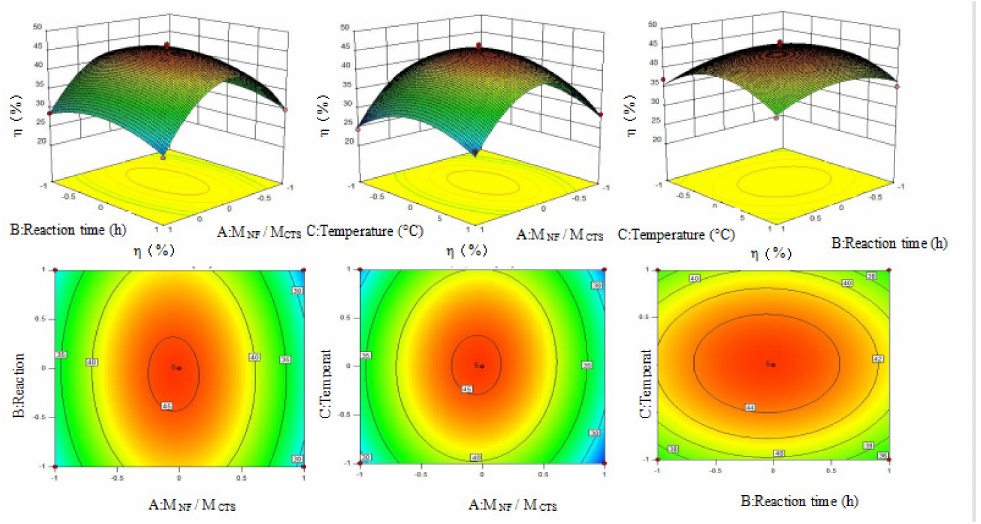
Figure 8. Three-dimensional effect surface plots of the dependent variable ( η %) and three independent variables (M NF /M CTS , T and